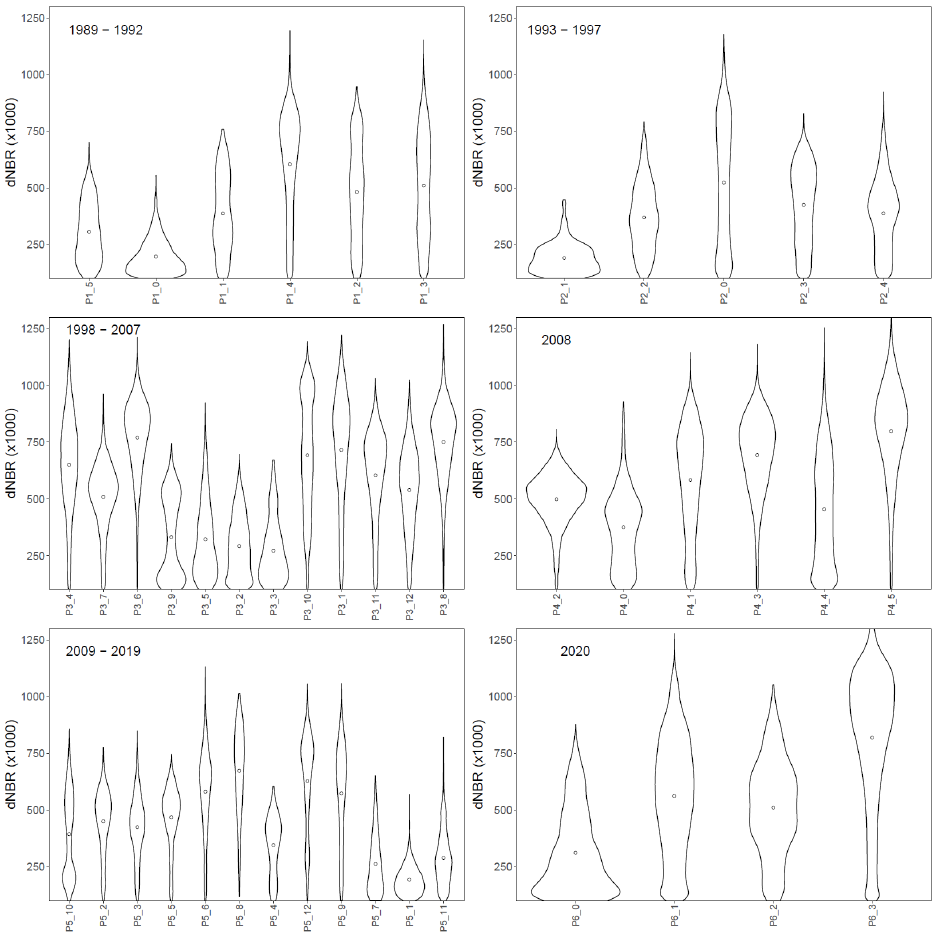
Figure A2. Violin plots showing the distribution of burn severity ( dNBR ) around the mean for all recorded fires. Split into six periods, as in Figure 7.